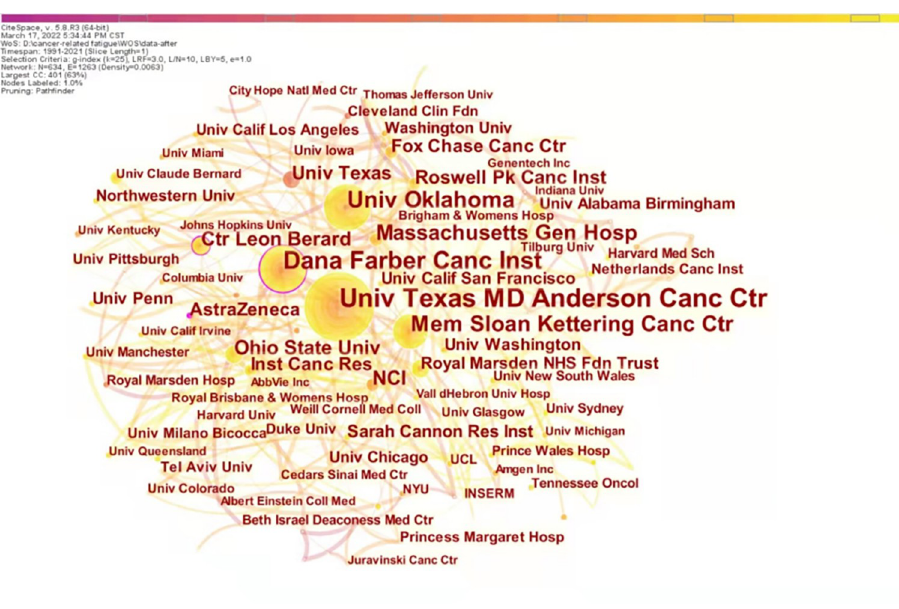
Fig 3. Map of research institutions in cancer-related fatigue in ovarian cancer